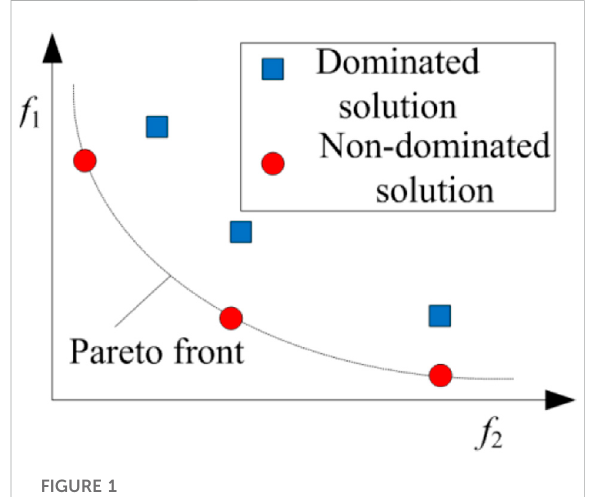
FIGURE 1 Pareto front of the two-objective-minimization